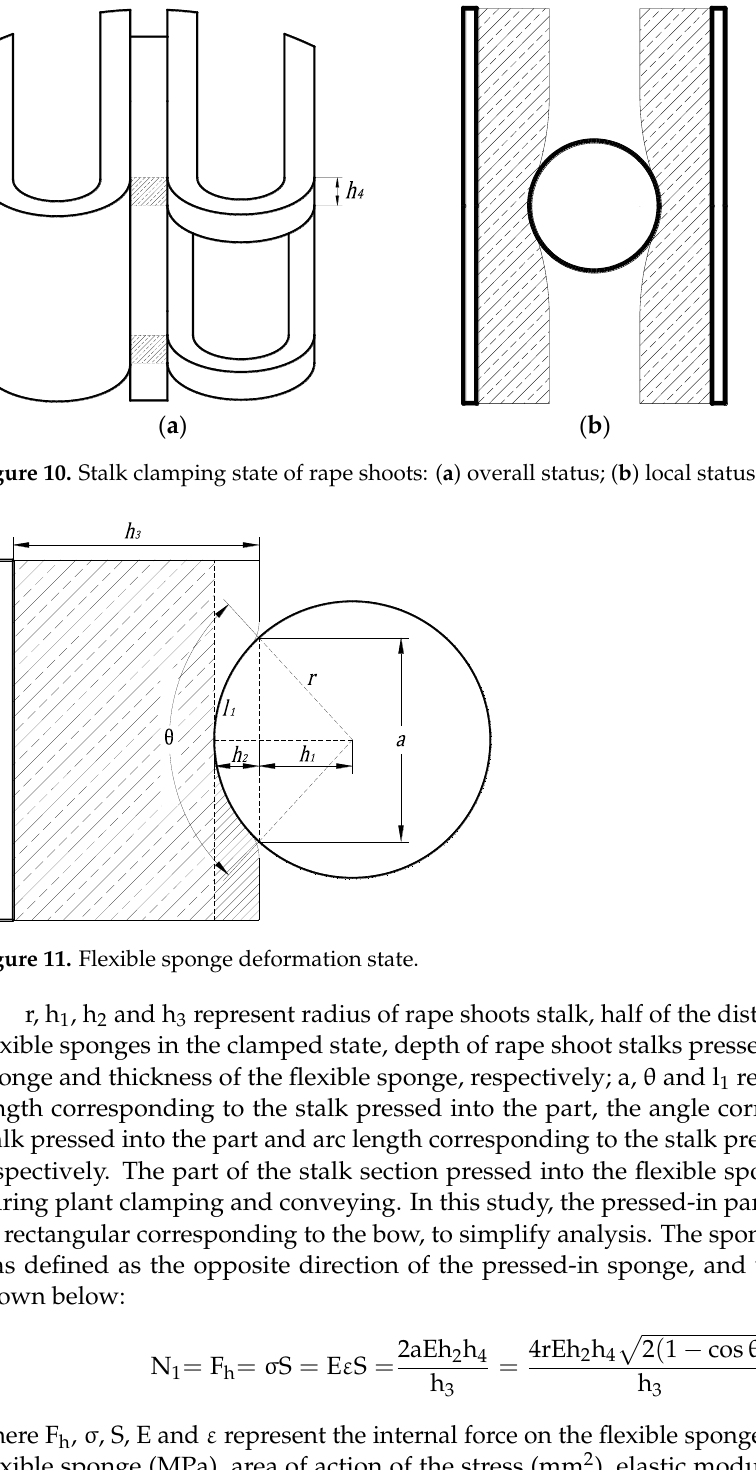
Figure 11. Flexible sponge deformation state.